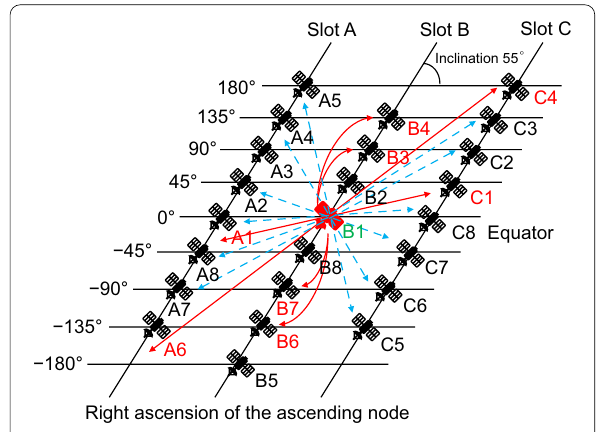
Right ascension of the ascending Fig. 5 The connection for C32 (M13, Slot-B1) between BDS-3 MEO satellites. The red solid line represents the continuous satellite links, while the blue dash line is the discontinuous